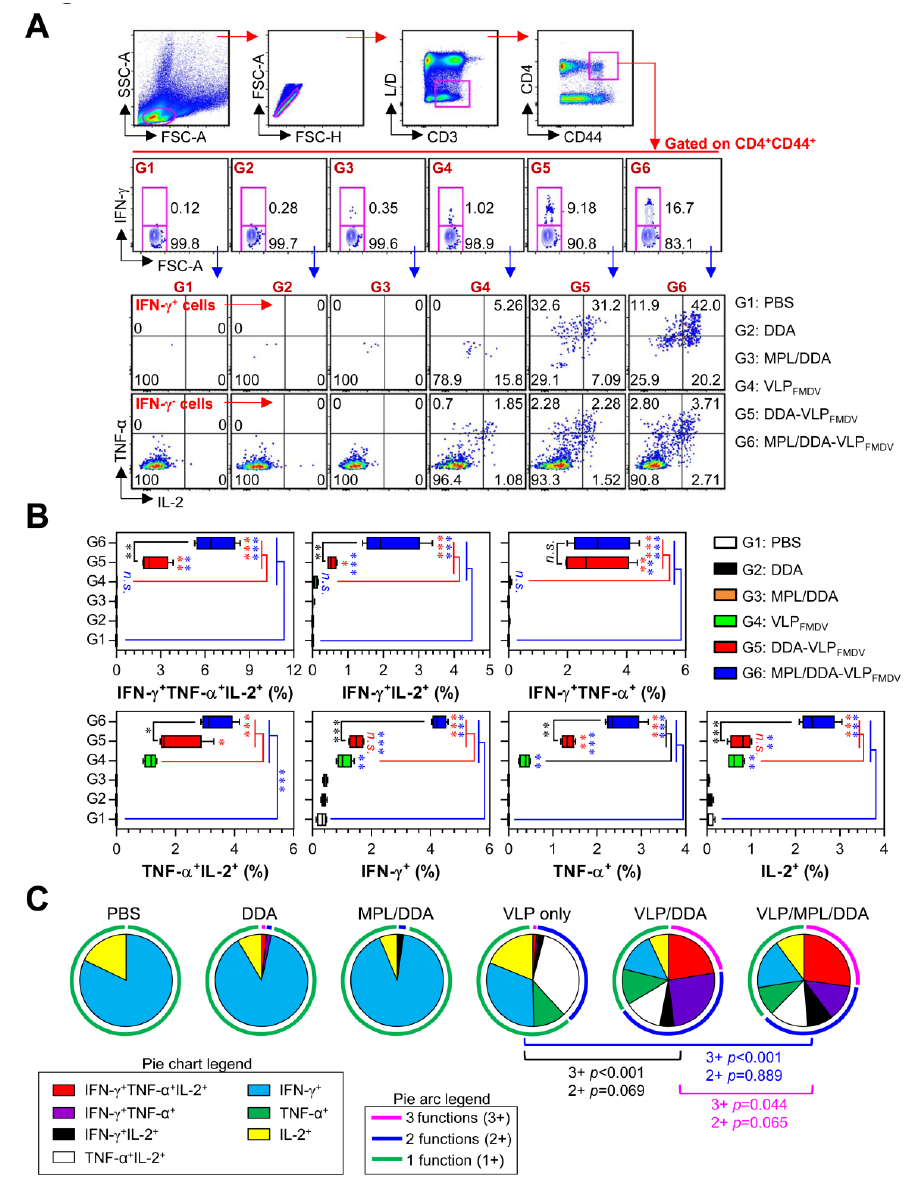
Figure 3. Analysis of antigen-specific multifunctional CD4 + T cells. ( A ) Gating strategy for multifunctional CD4 + memory T cells. Memory CD4 + T cells (determined by increased CD44 expression) gated to show CD3 + CD4 + CD44 + T cells. For multifunctional CD4 + T cells analysis, cells were identified by intracellular cytokine (IFN- γ , TNF- α , and IL-2) staining based on memory CD4 + T cell gating. ( B ) The percentage of VLP-specific total cytokine (IFN- γ , TNF- α , and / or IL-2)-producing cells among splenic CD4 + CD44 + memory T cells. ( C ) Pie charts representing the mean frequencies of cells co-expressing IFN- γ , TNF- α , and / or IL-2. The relative amounts of single-, double- and triple-functional CD4 + CD44 + memory T cells are indicated as pie arcs. Means ± SD ( n = 5 mice / group) shown are representative of two independent experiments. * p < 0.05, ** p < 0.01, *** p < 0.001. n.s.: not significant.